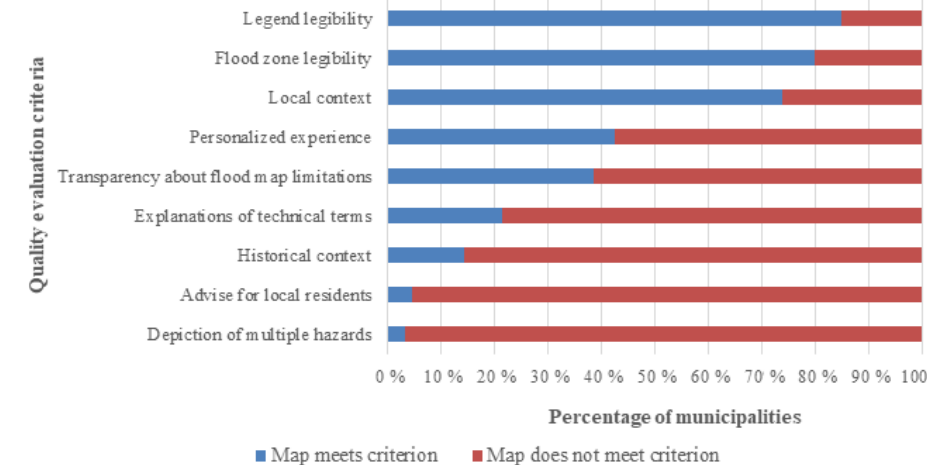
Figure 3. Characteristics of flood maps available to